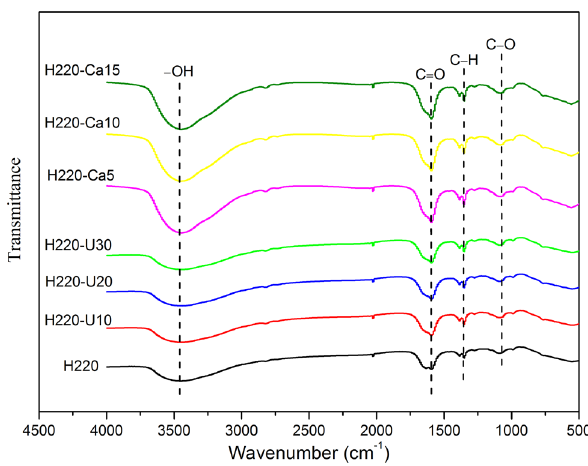
Figure 3: FTIR spectra of hydrochar resulting from HTC under dif - ferent